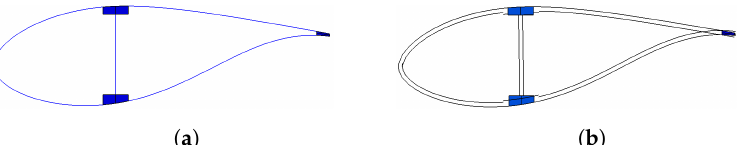
Figure 8. Visualisation of the shell and solid element distribution in a cross-section. ( a ) Visuali- sation of the shell and solid element distribution. ( b ) Visualisation of the virtual thickness of the shell